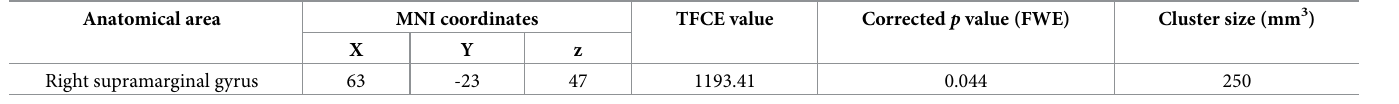
Table 3. Brain gray matter regions with a significant positive main effect of IAT score on volume. Anatomical area